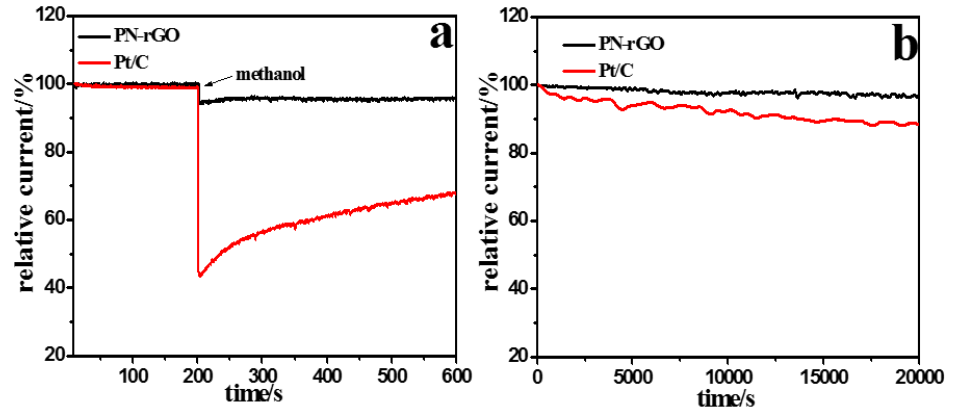
Figure 6. chronoamperometric responses of PN-rGO and Pt/C at − 0.3 V upon the addition of methanol ( a ), durability testing curves of PN-rGO and Pt/C for 20,000 s at 1600 rpm ( b